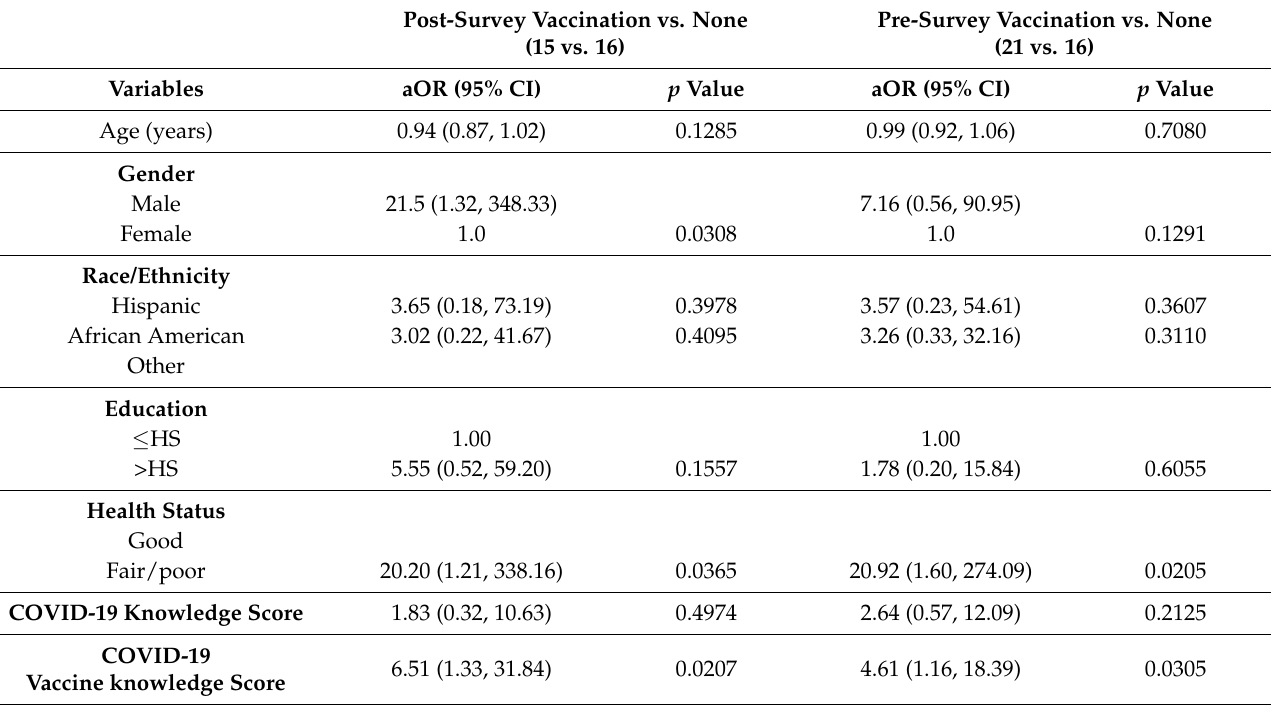
Table 3. Multinomial logistic regression model on vaccination status pre-survey vaccination and 6 months post-survey